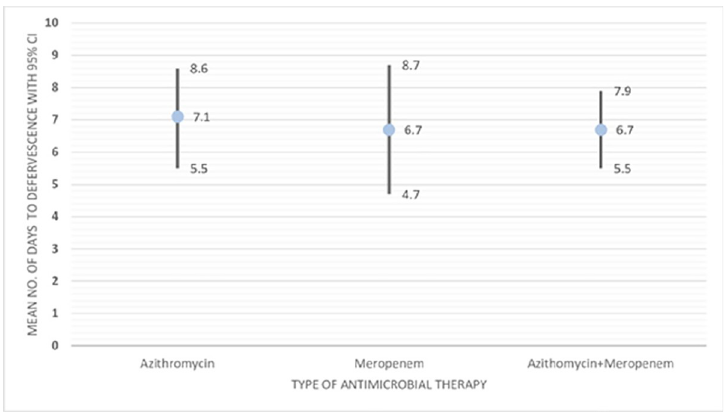
Fig 4. Comparison of time to defervescence across different types of antimicrobial therapy for treating XDR Typhoid patients.